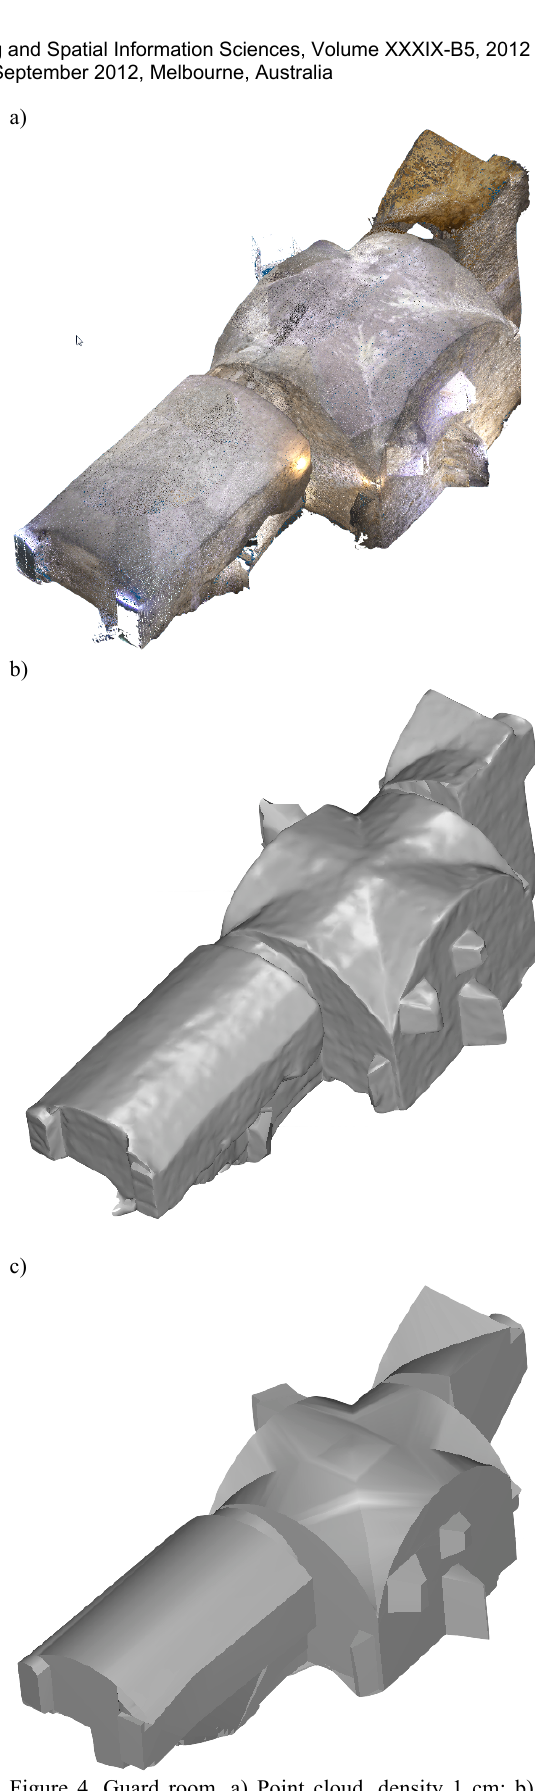
Figure 4. Guard room, a) Point cloud, density 1 cm; b) mesh applied to point cloud; c) Simplified